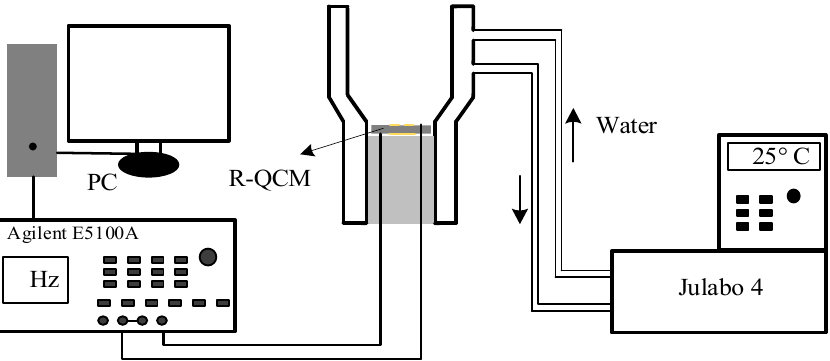
Figure 3. Measurements of resonance frequency and half-bandwidth.